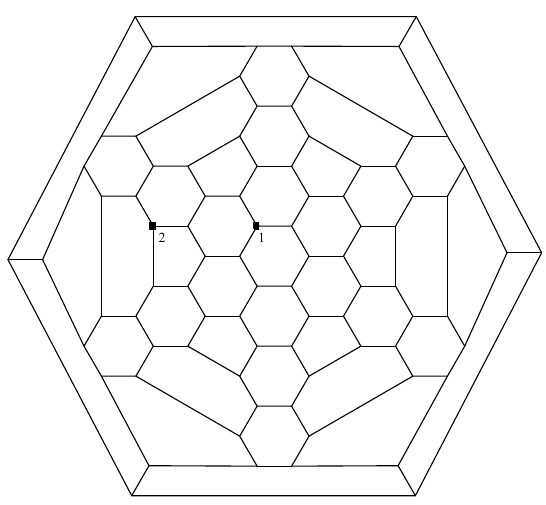
= 3. 24 n + 12 , for n